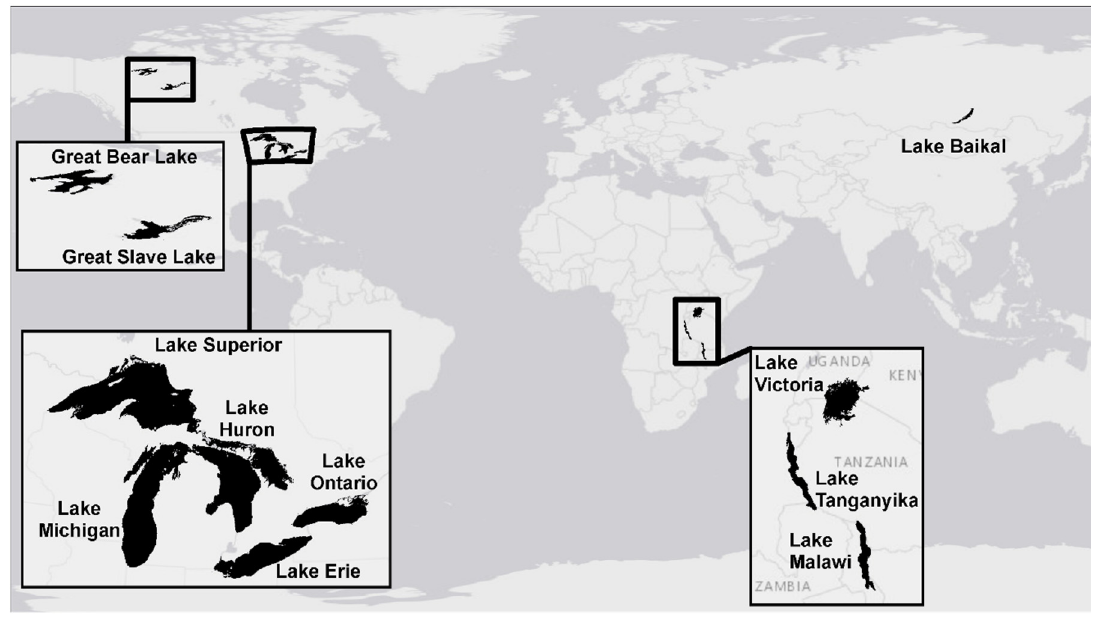
Figure 1. Locations of the 11 lakes included in this study.